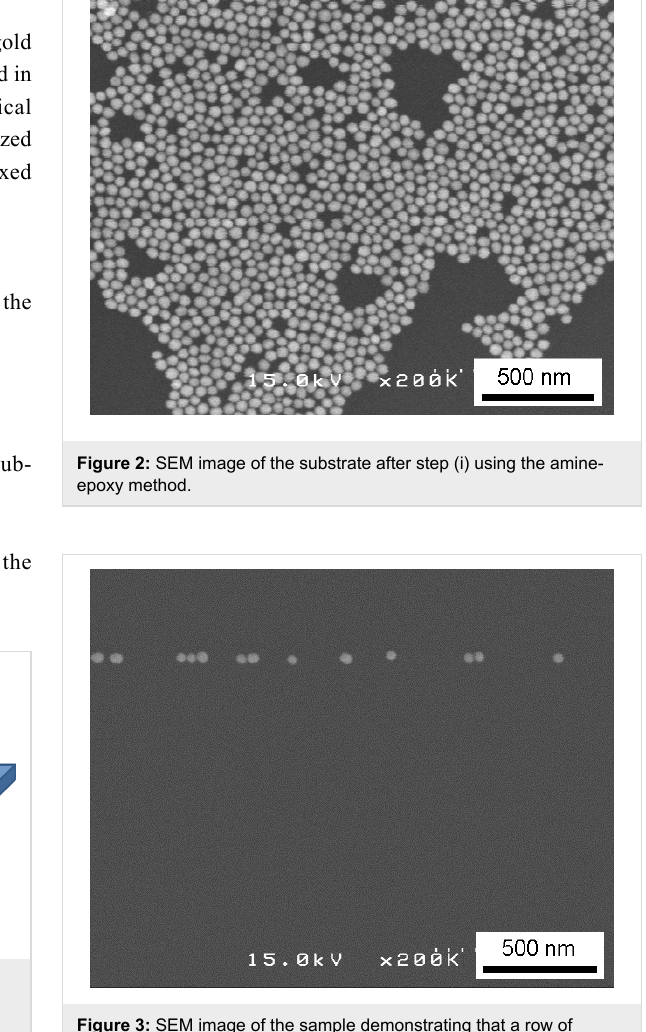
Figure 3: SEM image of the sample demonstrating that a row of nanoparticles was formed after step (iii), wherein the sample was irra- diated and